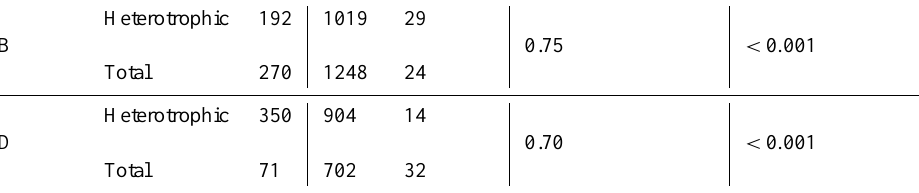
∗ By accounting water table depth as covariate at B and D